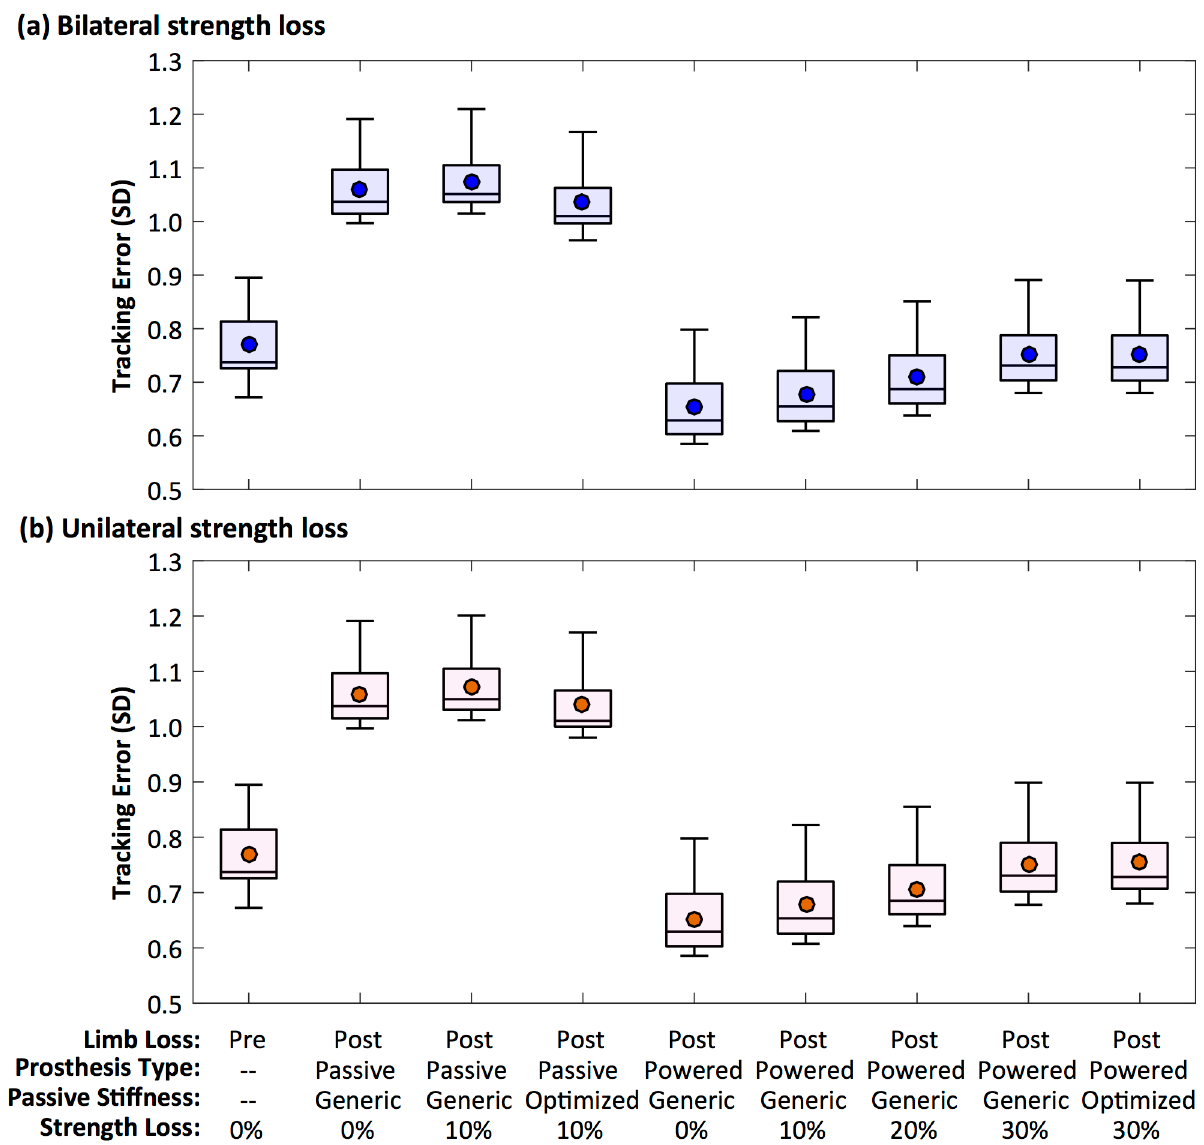
Fig 6. Tracking errors. Box plots of tracking errors for different prosthesis types, passive prosthetic ankle stiffness, and level of strength loss. Panel (a) is simulations of bilateral strength loss. Panel (b) is simulations of unilateral strength loss, on the side of the residual limb. The symbol within each box is the